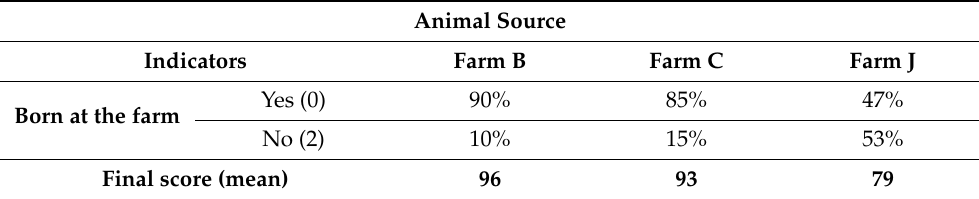
Table 7. Results of the three farms regarding the origin of their